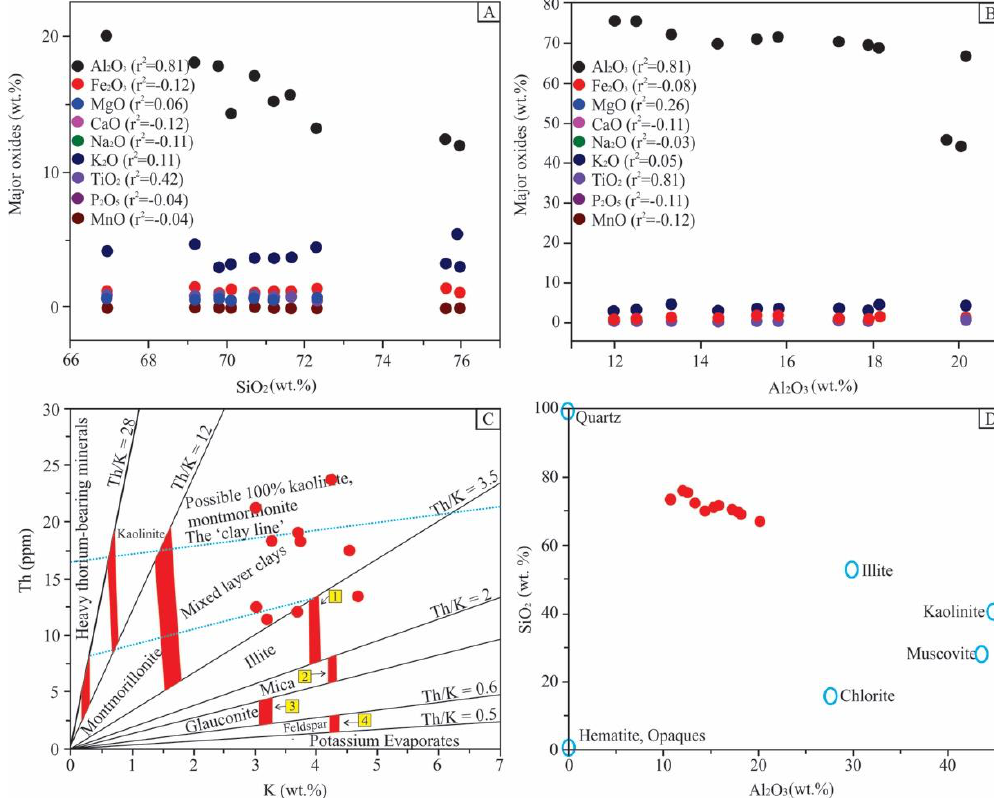
Figure 6. Cross-plots illustrating ( A ) SiO 2 correlation with major oxides; ( B ) Al 2 O 3 correlation with major oxides; ( C ) K (wt.%) vs. Th (ppm) [49]; ( D ) Al 2 O 3 vs. SiO 2 (wt.%) representing the clay type in black shale samples [50].